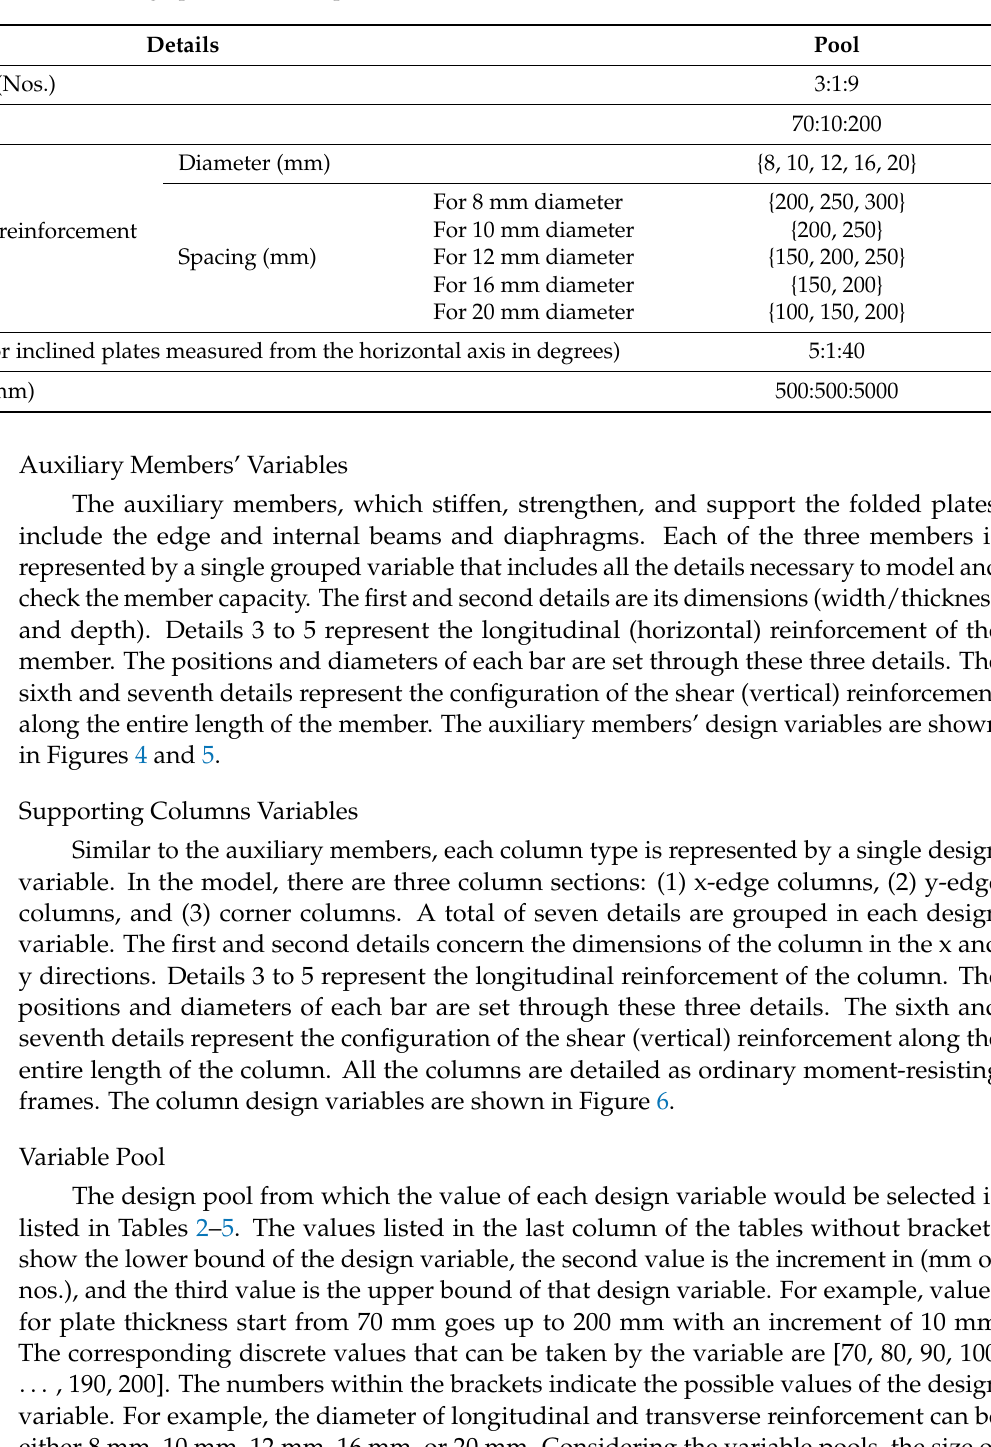
Table 2. Design pools of folded plate